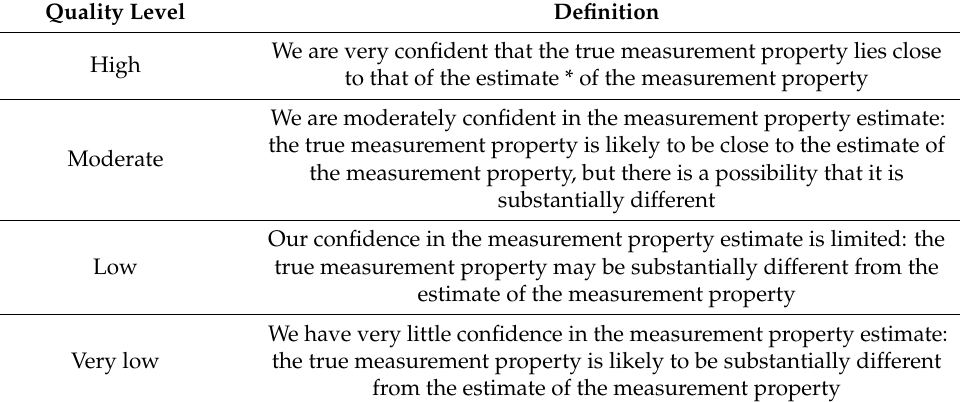
Table 2. Definitions of quality